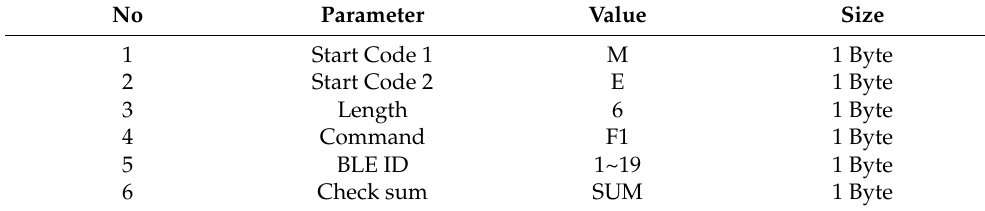
Table 5. BLE ID setting